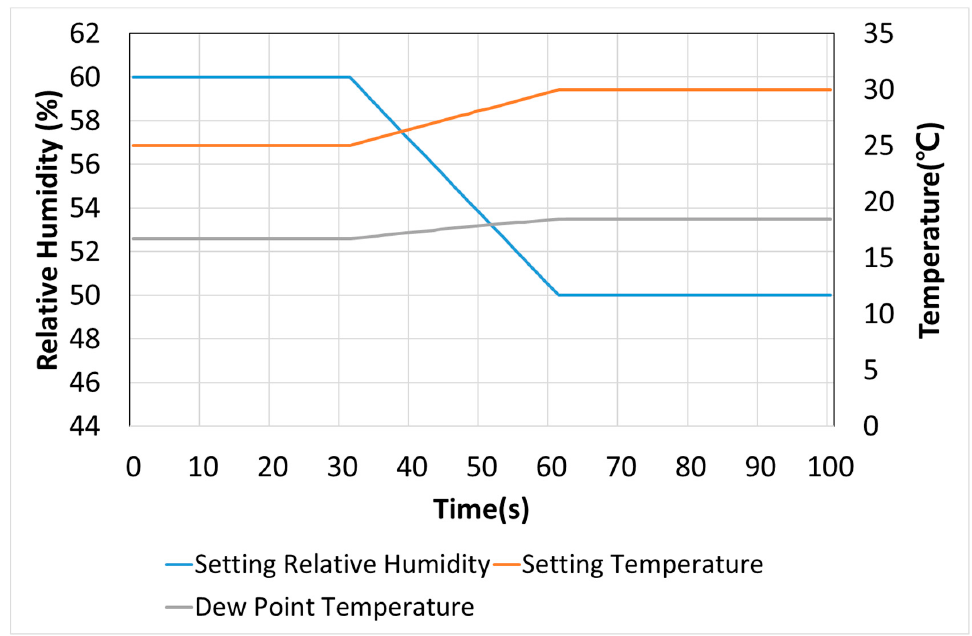
Figure 17. Condition of changing temperature and humidity.